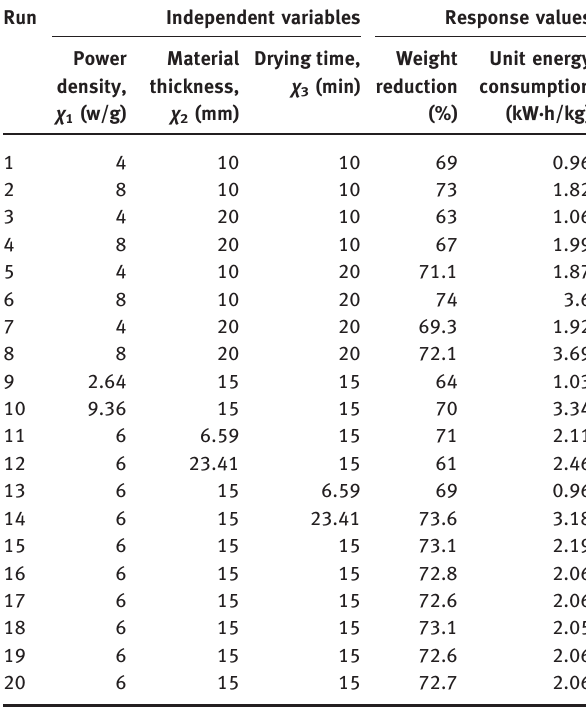
Table 2: Experimental design matrix and